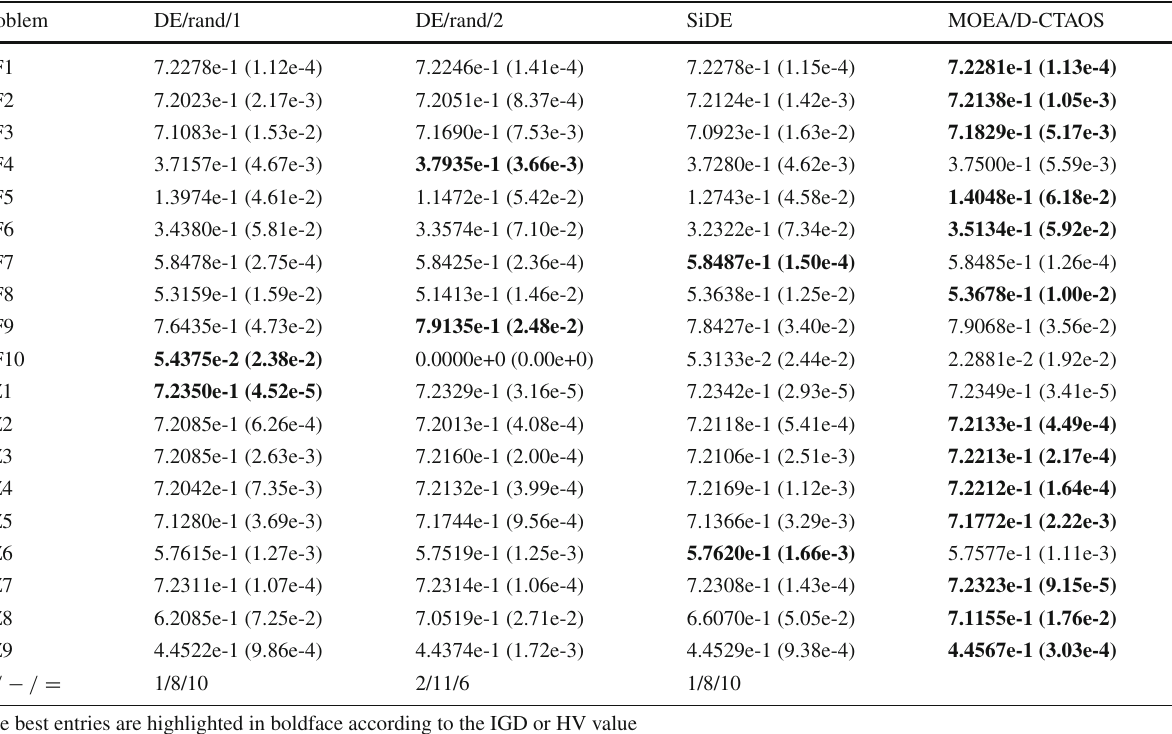
The best entries are highlighted in boldface according to the IGD or HV value